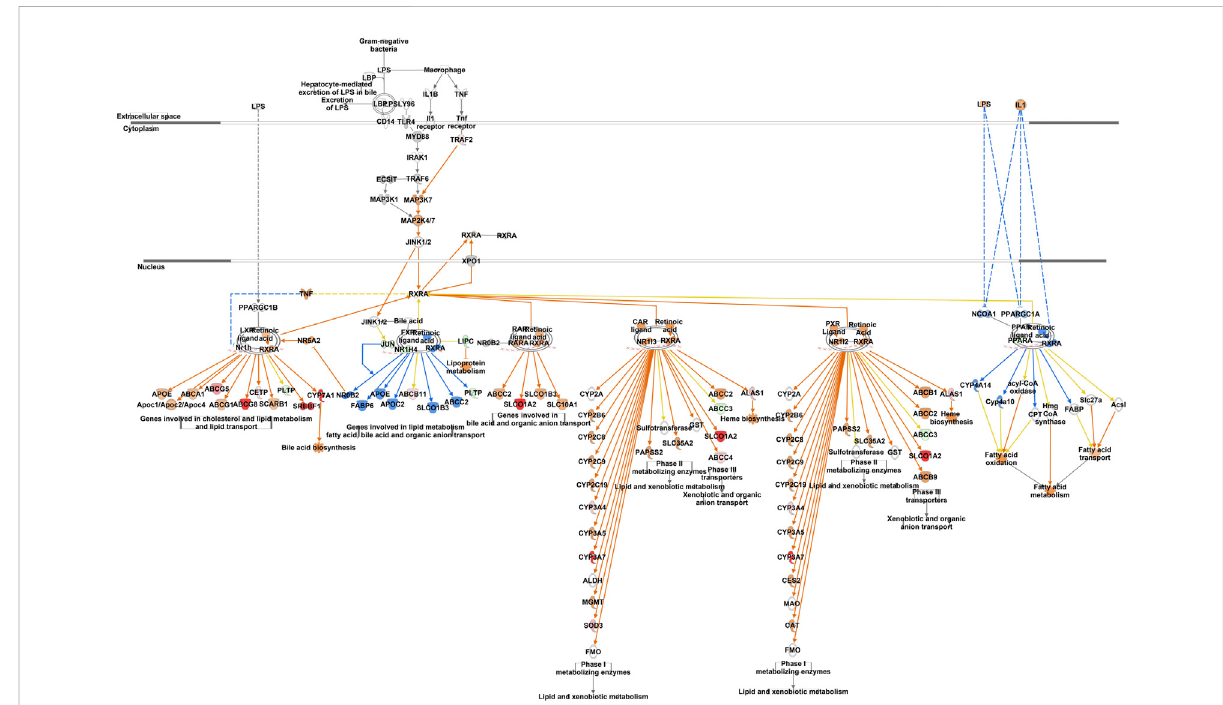
FIGURE 8 Network mapping of differentially expressed genes associated with RXR function between DLY chicks and E18 embryos. Network mapping of differentially expressed genes (fold-change ≥ 5; FDR p -value ≤ 0.05) associated with RXR function between DLY chicks and E18 embryos. Red molecules weresigni fi cantly upregulatedand green moleculessigni fi cantly downregulatedinDLY chicks.Orangeindicatespredicted activation and blue indicates predicted